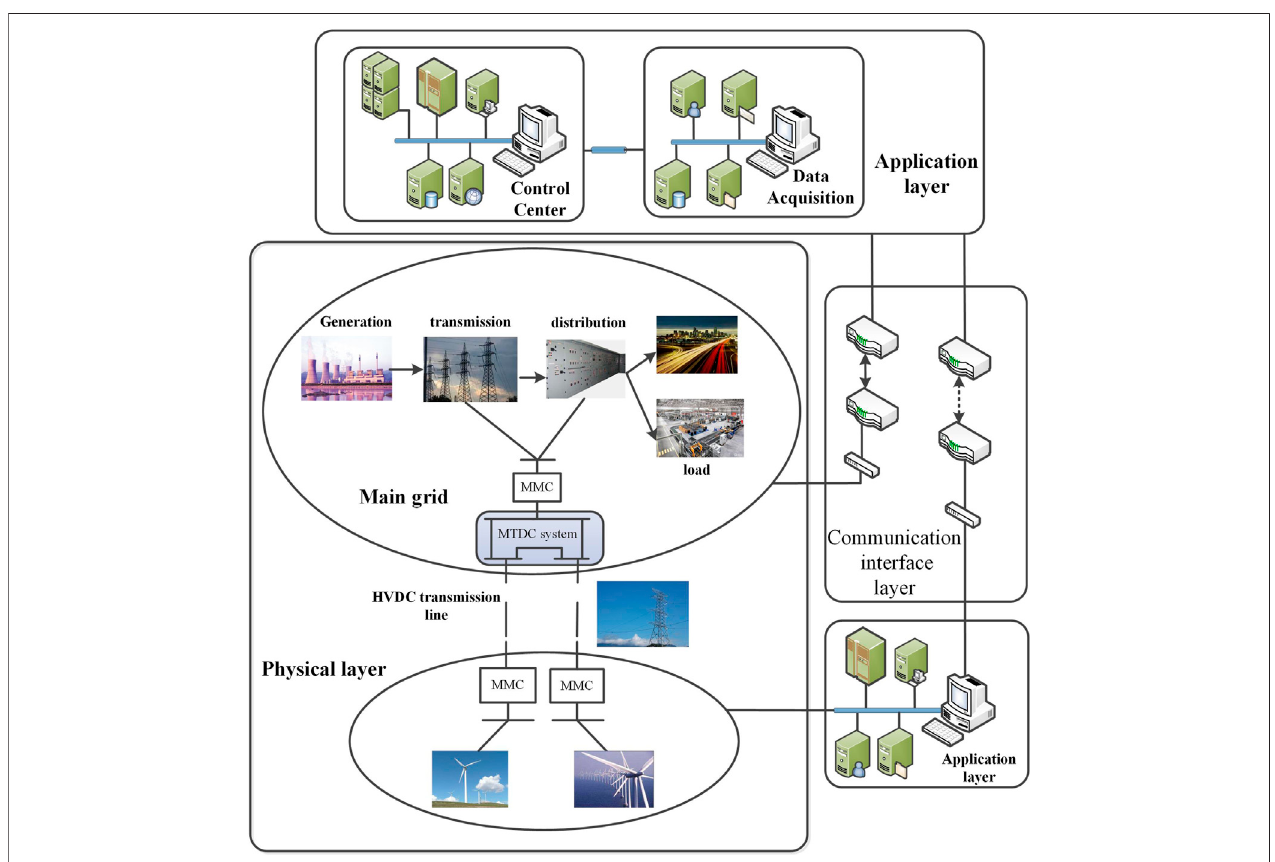
FIGURE 1 | Cyber – physical power system with the MMC – MTDC main